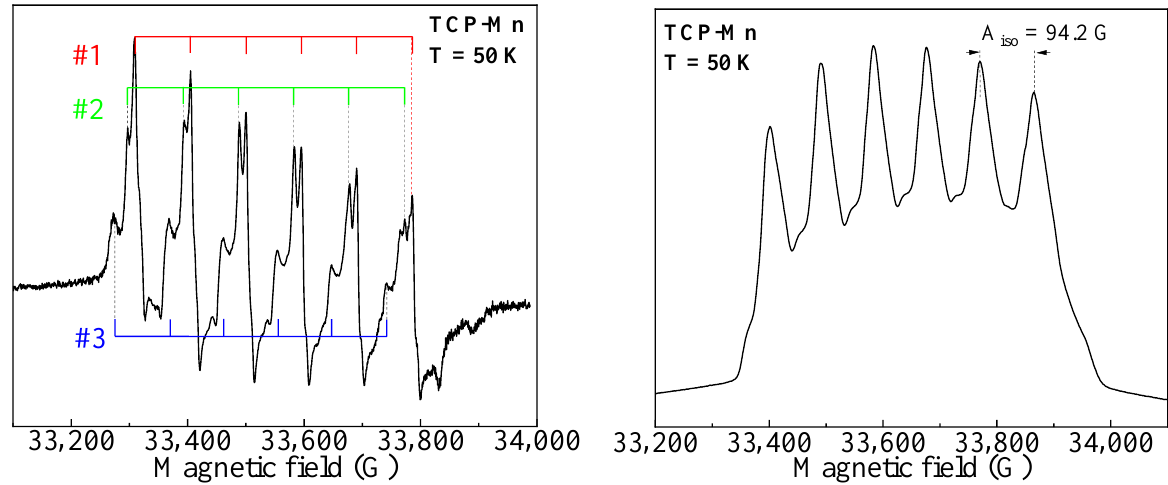
Figure 5. Spectra of high-frequency EPR of hyperfine interaction for the central transition of the fine structure of manganese for 0.001MnTCP in cw ( left panel ) and ESE ( right panel ) modes.